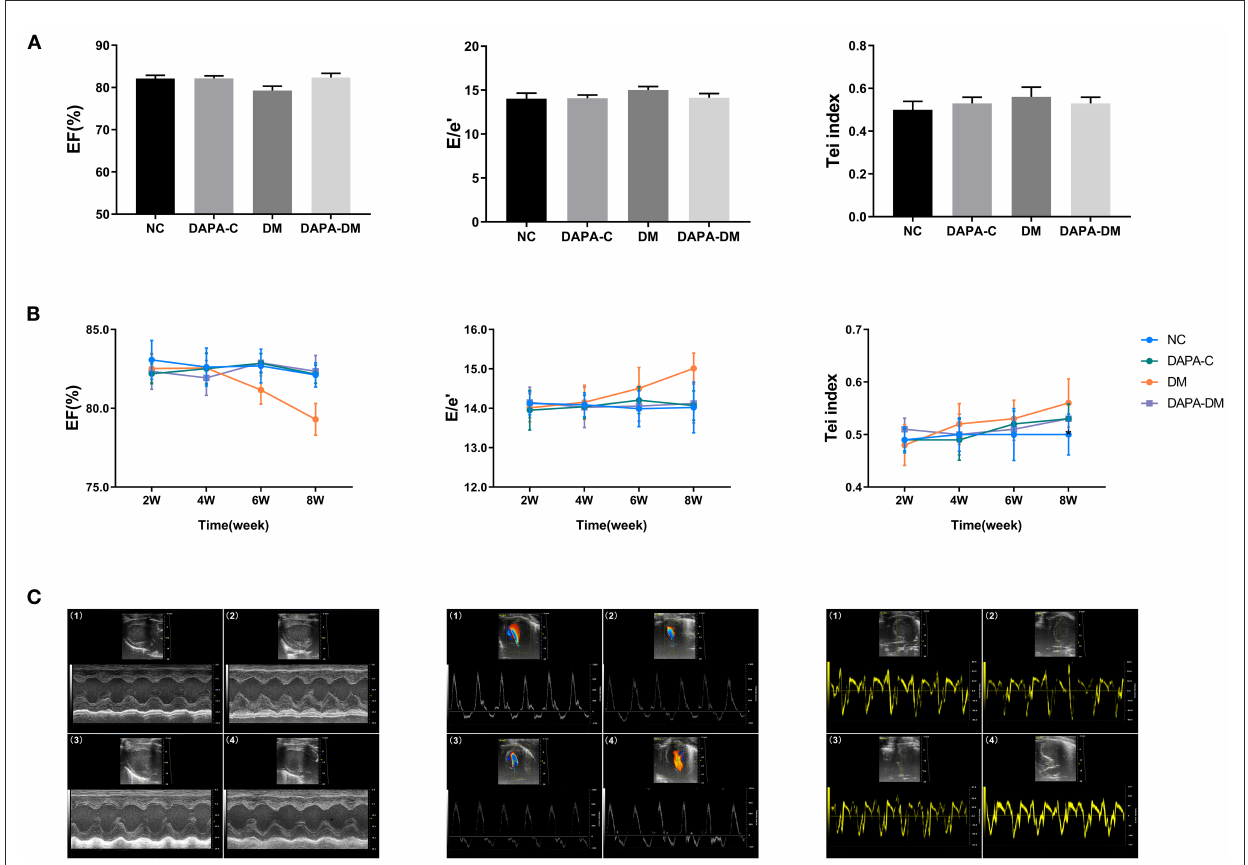
FIGURE2 Comparison of conventional echo-Doppler data among groups. (A) EF, E/e’, and Tei of the four groups at different time points. (B) Differences in EF, E/e’, and Tei among the four groups at different time points. (C) Representative M-mode images, spectral Doppler images, and tissue Doppler images of the four groups at 8 weeks. (1) normal control group, (2) DAPA-control group, (3) diabetic group, (4) DAPA-diabetic group. EF, ejection fraction; E, peak flow velocity; e’, myocardial motion velocity; Tei, Tei index; NC, normal control group; DAPA-C, DAPA-control group; DM, diabetic group; DAPA-DM, DAPA-diabetic